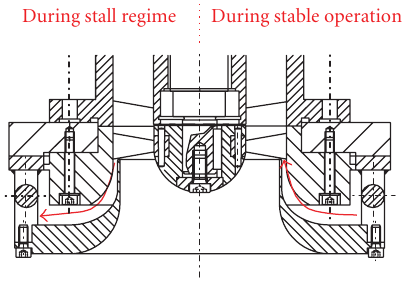
Figure 6: Design drawing of double-inlet-nozzle.